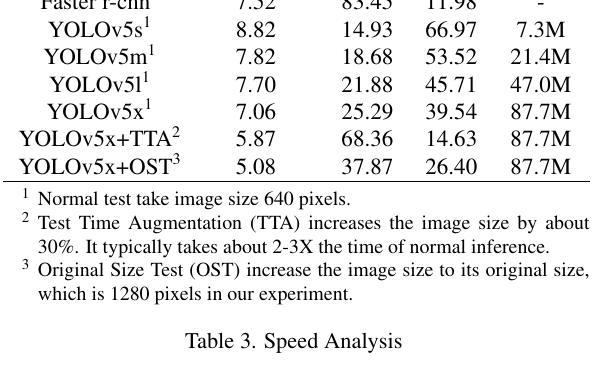
Table 1. Object height predictions and ground truths In case study II, the height estimation is performed sequentially.